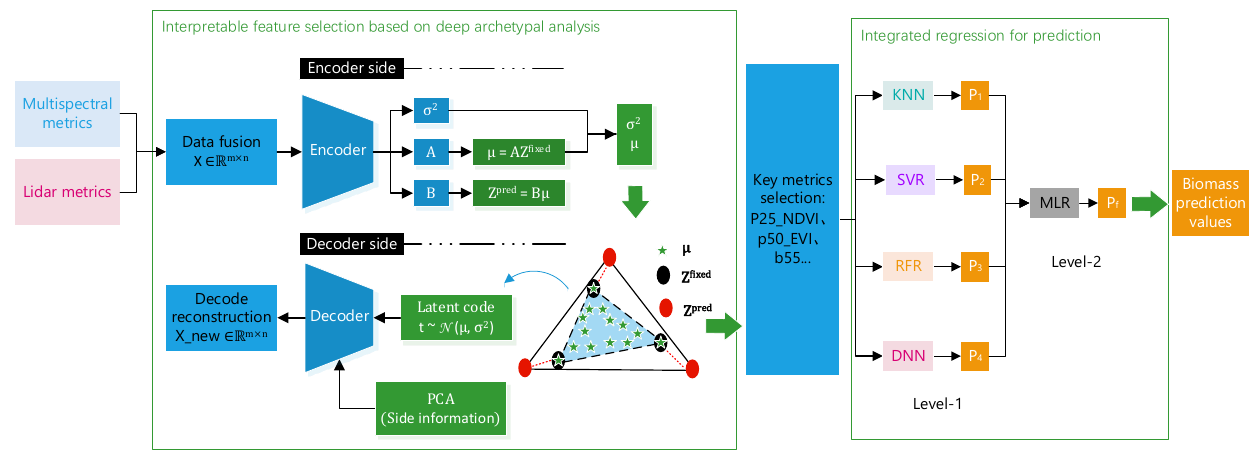
Figure 1. Workflow diagram of the proposed biomass prediction method with the number of archetype parameters set to three as an example. P i , (i = 1, 2, 3, 4) are regression model